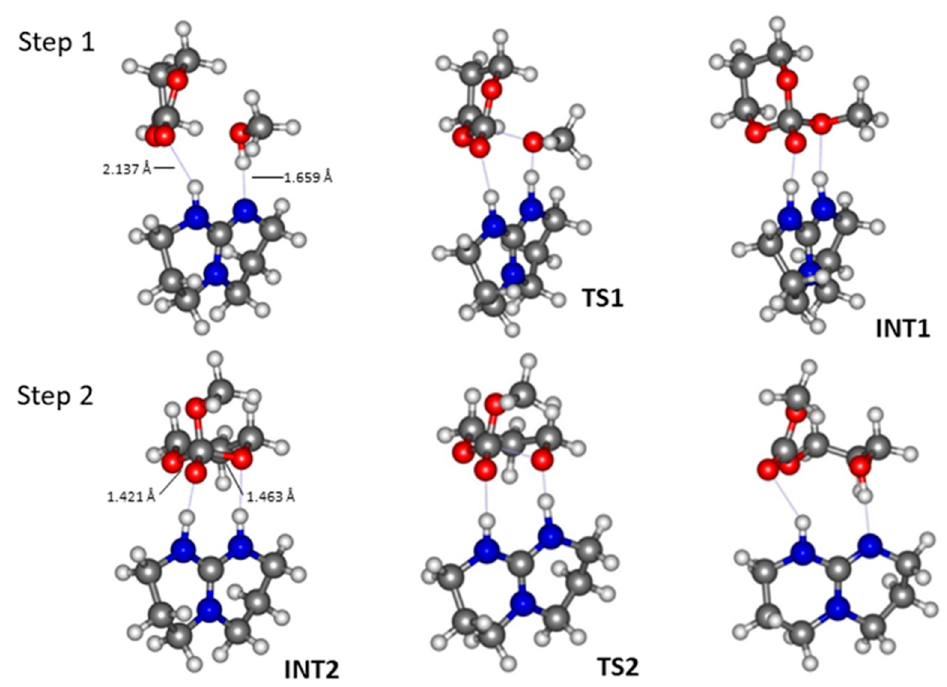
Figure 1. Optimized geometry structures of the species involved in the TBD catalysed ring-opening polymerization for the TMC—H-bond/alcohol activation mechanism. Colour code: C grey, O red, N blue and H white.